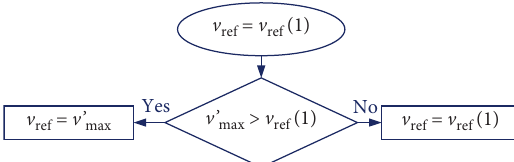
Figure 8: Algorithm flowchart of finding new reference voltage when there is an